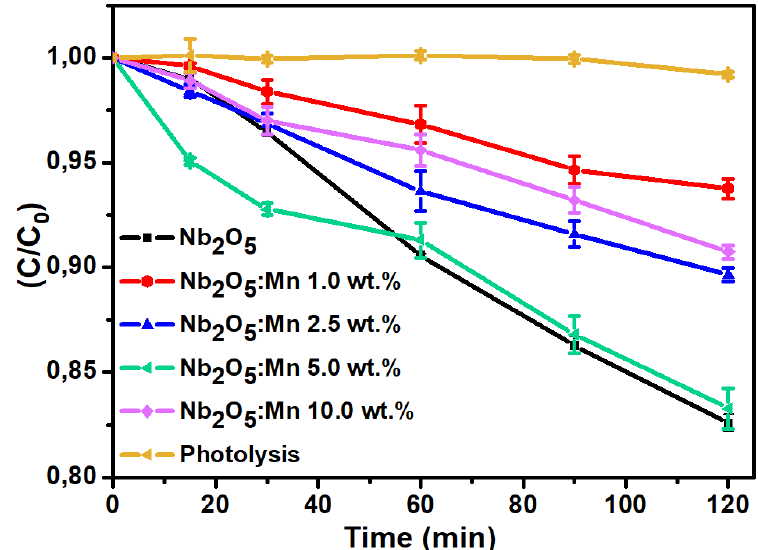
Figure 10. Kinetic graphs of Rhodamine B photodegradation, for the pure sample and with the different percentages of the addition of Mn at 700 ◦